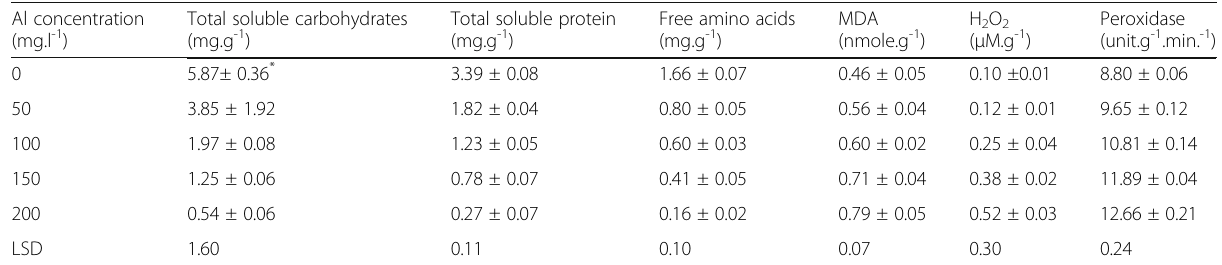
Table 2 Carbohydrates, protein, free amino acids, malondialdehyde, H2O2 contents and peroxidase activity of date palm callus in response to Al stress Al concentration (mg.l -1